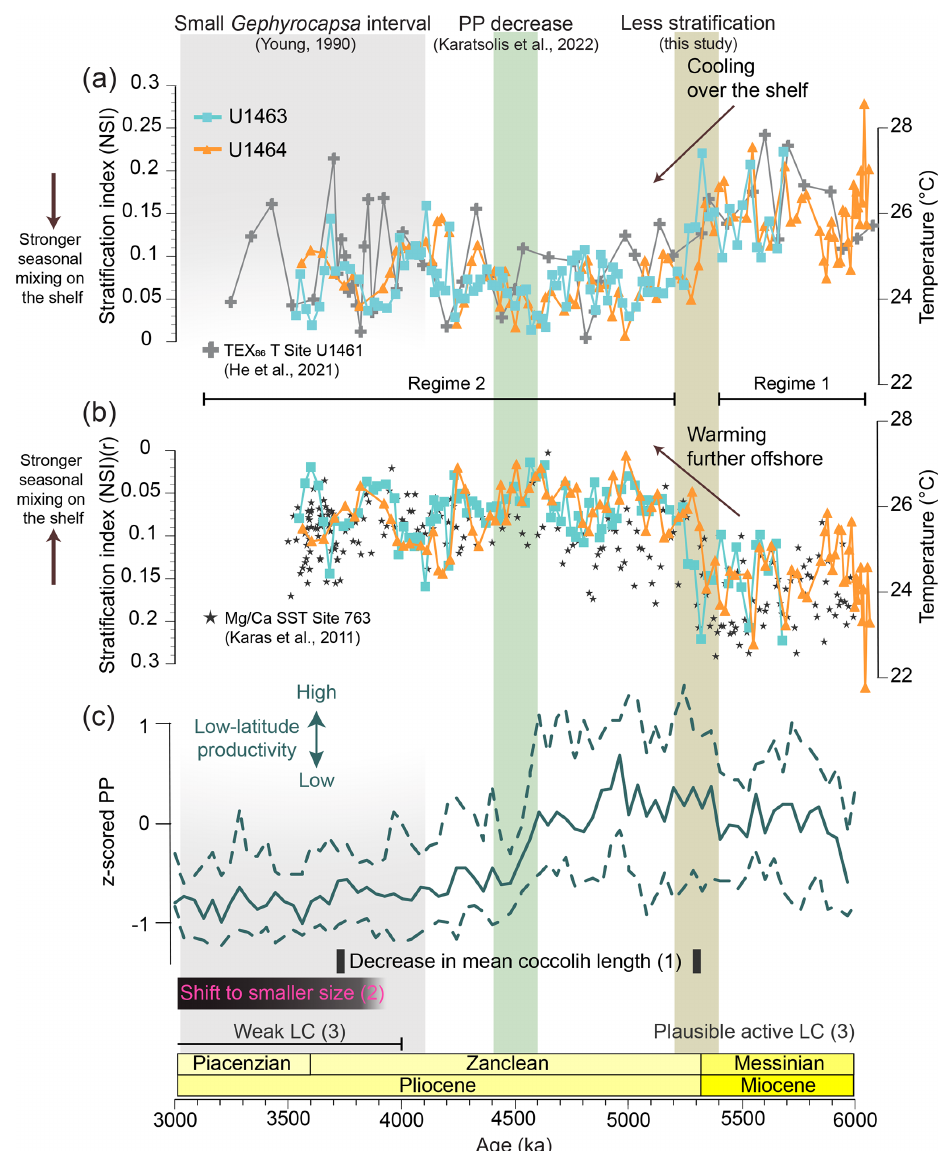
Figure 7. Correlation between paleotemperature proxies for the eastern Indian Ocean, water column stratification over the NW Australian shelf (NSI), and low-latitude paleoproductivity (PP). (a) Nannofossil stratification index (NSI) at IODP Sites U1463 (in blue) and U1464 (orange) and TEX 86 -derived temperature ( ◦ C) at IODP Site U1461 (He et al., 2021), located on the NW Australian shelf (grey). (b) NSI – as in panel (a) , but note the reversed ( r ) scale of the y axis – and Mg / Ca-derived ( Trilobatus sacculifer ) SST ( ◦ C) at ODP Site 763 (Karas et al., 2011), located near the NW Australian shelf but further offshore to the west of the Exmouth Plateau (grey stars). Horizontal black lines mark the suggested overall different paleoceanographic regimes before and after the Miocene–Pliocene boundary: Regime 1, with the more stratified, weaker Leeuwin Current (LC); and Regime 2, with the less stratified, stronger LC. (c) Standardised median PP in low latitudes in all major ocean basins (Karatsolis et al., 2022). Dashed lines indicate the 15.9 and 84.1 percentiles (i.e., the central 68.2 percentiles) of the compiled data. Black bars indicate (1) a distinct decrease in mean and maximum coccolith length, as recorded in the Indian Ocean (Young, 1990), and (2) a period of permanent shift to smaller-sized nannofossils (Aubry, 2007). The black line illustrates (3) the postulated LC intensity for the NW Australian shelf area in an earlier study (He et al., 2021). Vertical shadings indicate the stepwise decrease in NSI (brown), the decrease in low-latitude PP and nannofossil fluxes over the NW Australian shelf (green), and the small Gephyrocapsa dominance interval recorded in the Indian Ocean (grey; Young,